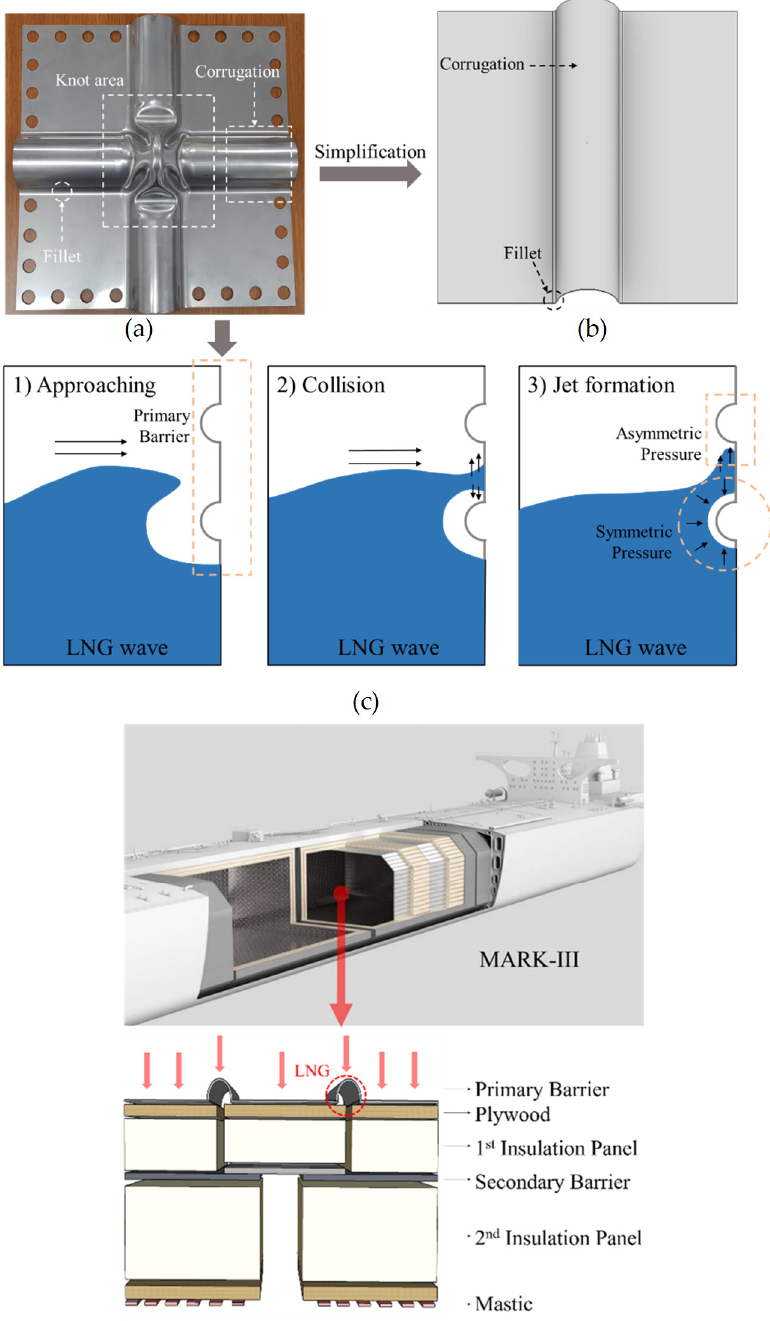
Figure 1. ( a ) Photograph of the primary barrier. ( b ) Simplified primary barrier without knot area for FEA. ( c ) Schematic of hydrodynamic loading caused by ship motion. The black arrow represents the flow direction. ( d ) Schematic of the membrane-type LNG CCS [9]. Lee et al. evaluated the deformation of the primary barrier knot area and determined the direction of maximum deformation under uniform-pressure conditions [10]. Similarly, Jeong et al. conducted a uniform pressure test with a custom-built facility and numerically analyzed the deformation characteristics of the corrugated sheet via finite element analysis (FEA) [10]. Kim et al. investigated the plastic structural behavior of the primary barrier under repeated impact conditions at a large-scale weight drop facility [11]. Brossel et